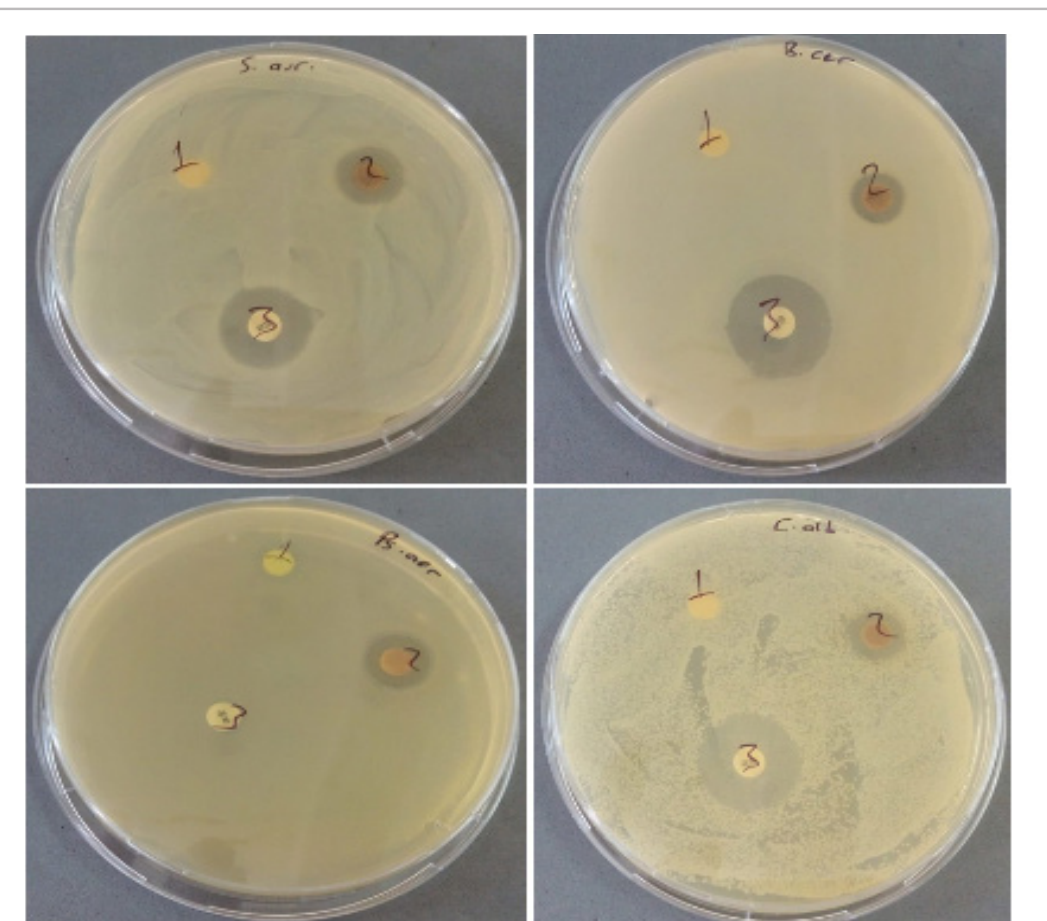
FIGURE 7 - Some images obtained by the disk diffusion